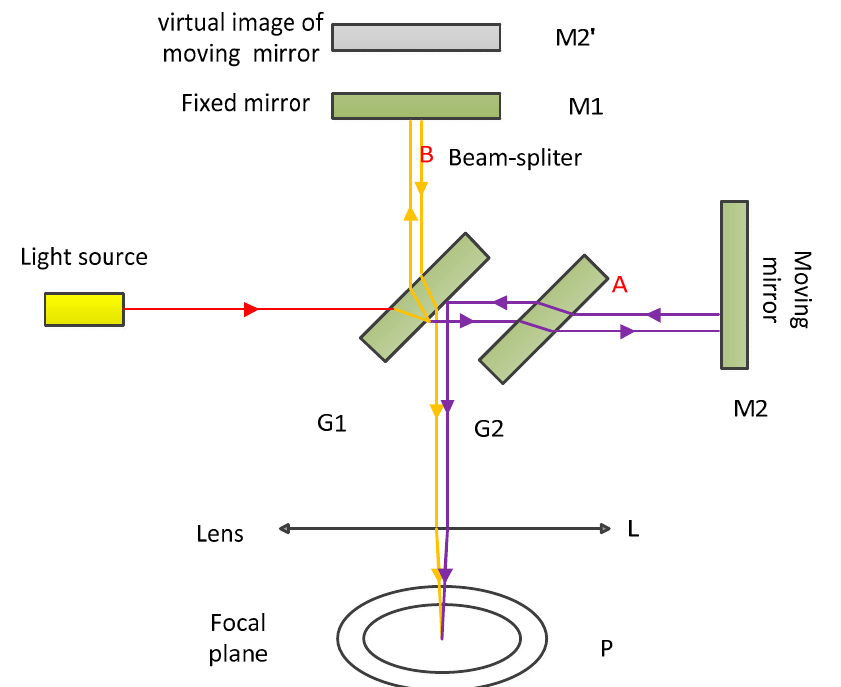
Figure 1. Schematic diagram of the Michelson interferometer.